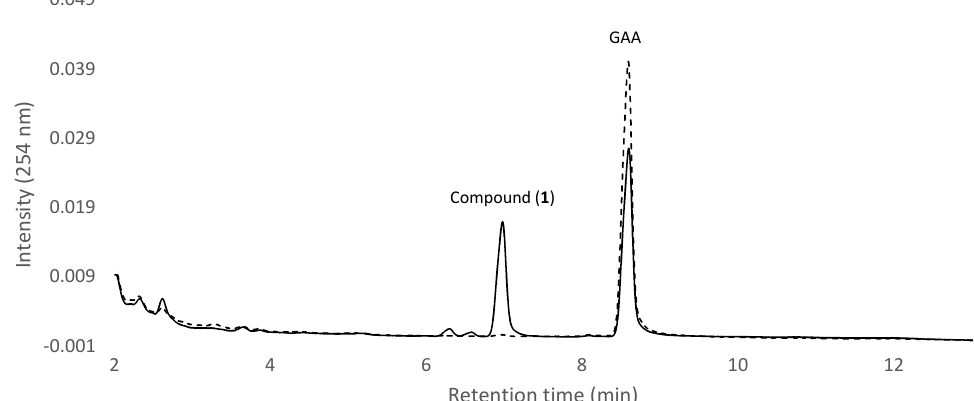
Figure 1. Biotransformation of ganoderic acid A (GAA) using the intestinal isolated bacteria GA A07 strain. The strain was cultivated in Luria-Bertani (LB) media containing 100 mg/L of GAA. The initial (dashed curve) and 24 h (solid curve) cultivations of the fermentation broth were analyzed with ultra-performance liquid chromatography (UPLC). The UPLC operation conditions are described in the Materials and Methods.